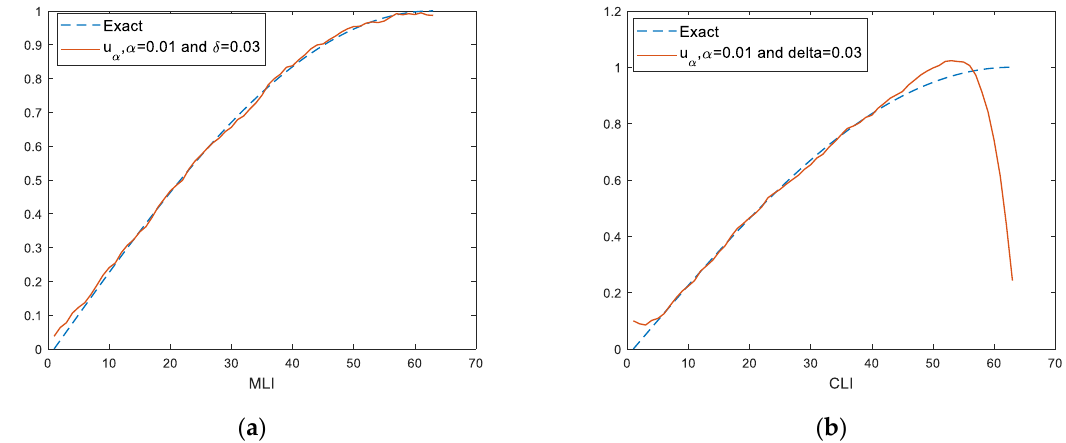
Figure 3. Approximation solution with 10,000 iterations: ( a ) MLI algorithm; ( b ) CLI algorithm. In Figure 4, the iterations increased to 20,000.